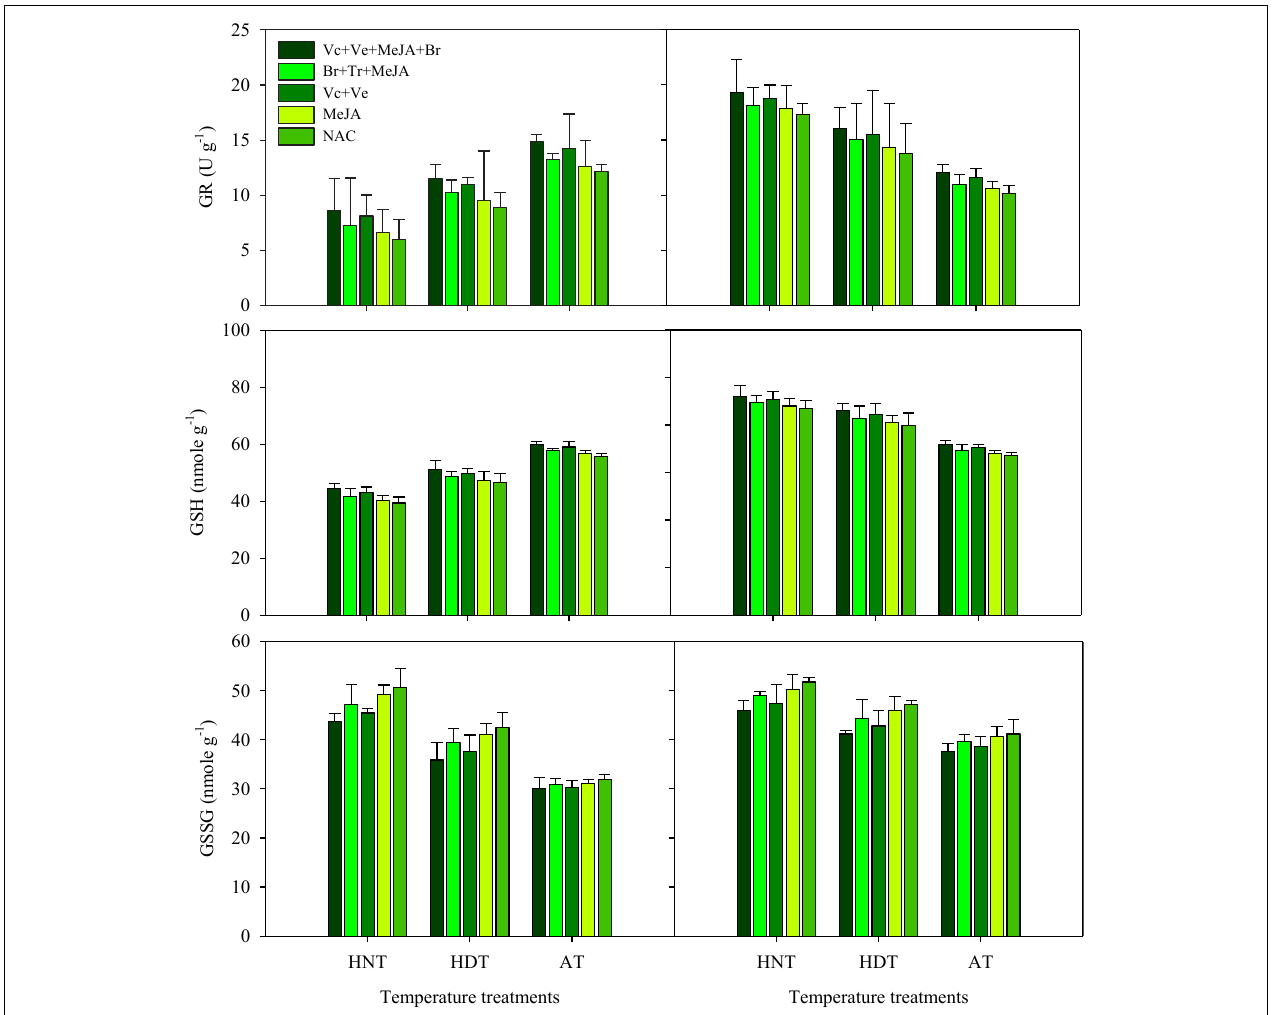
FIGURE 3 | Glutathione (GSH), glutathione reductase (GR), and glutathione disulfide (GSSG) levels in rice leaves as affected by growth regulators under heat stress. HDT, HNT, and AT stand for high day, high night, and ambient temperature, respectively. The lines on bars represent LSD value for the interaction of PGRs and heat stress (heat stress × PGR) at α =